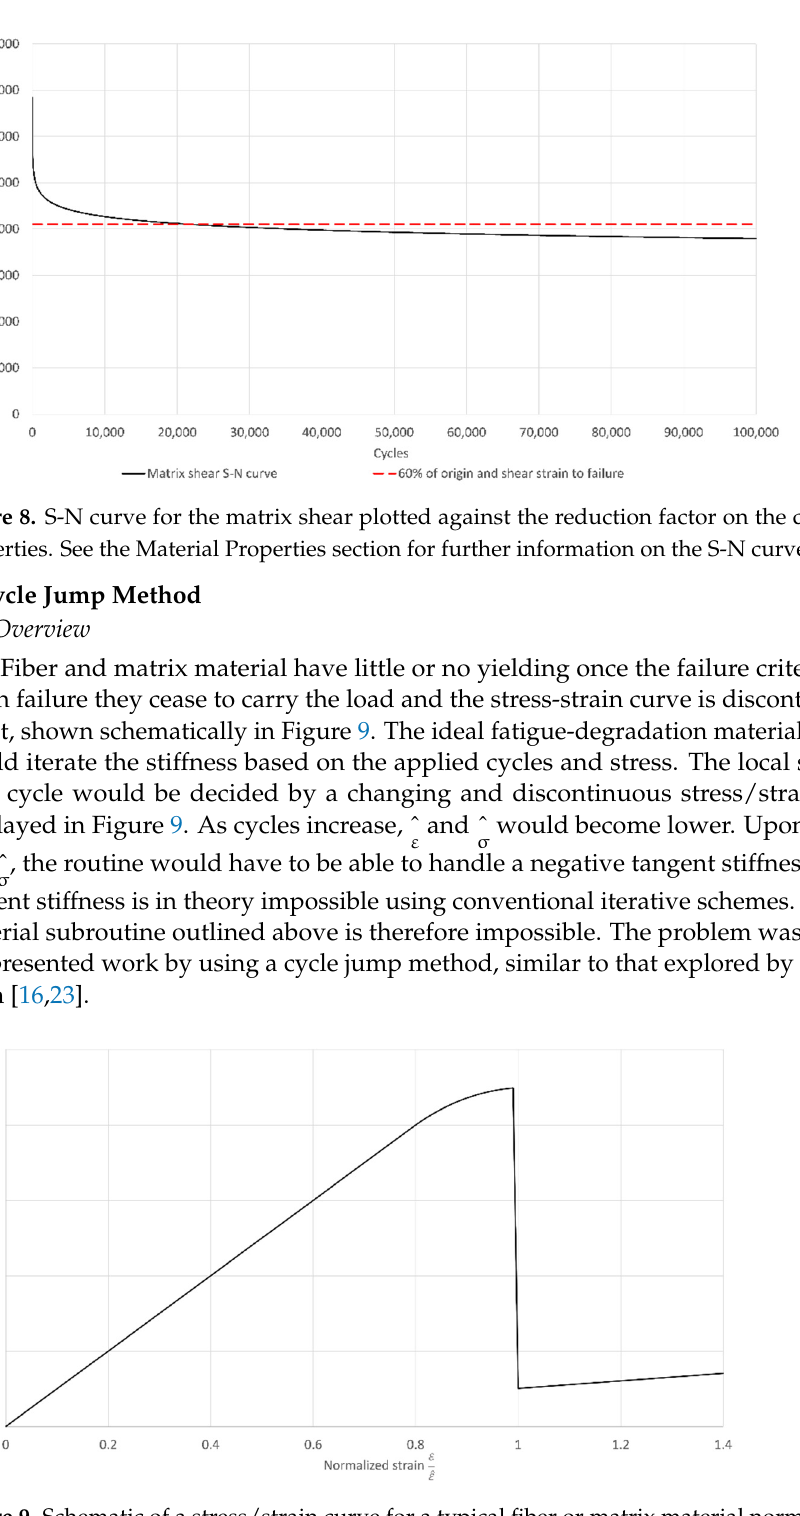
Figure 7. The shape and variables in the traction-separation response. The values on the axis are for the normal component in the traction separation contact definition.